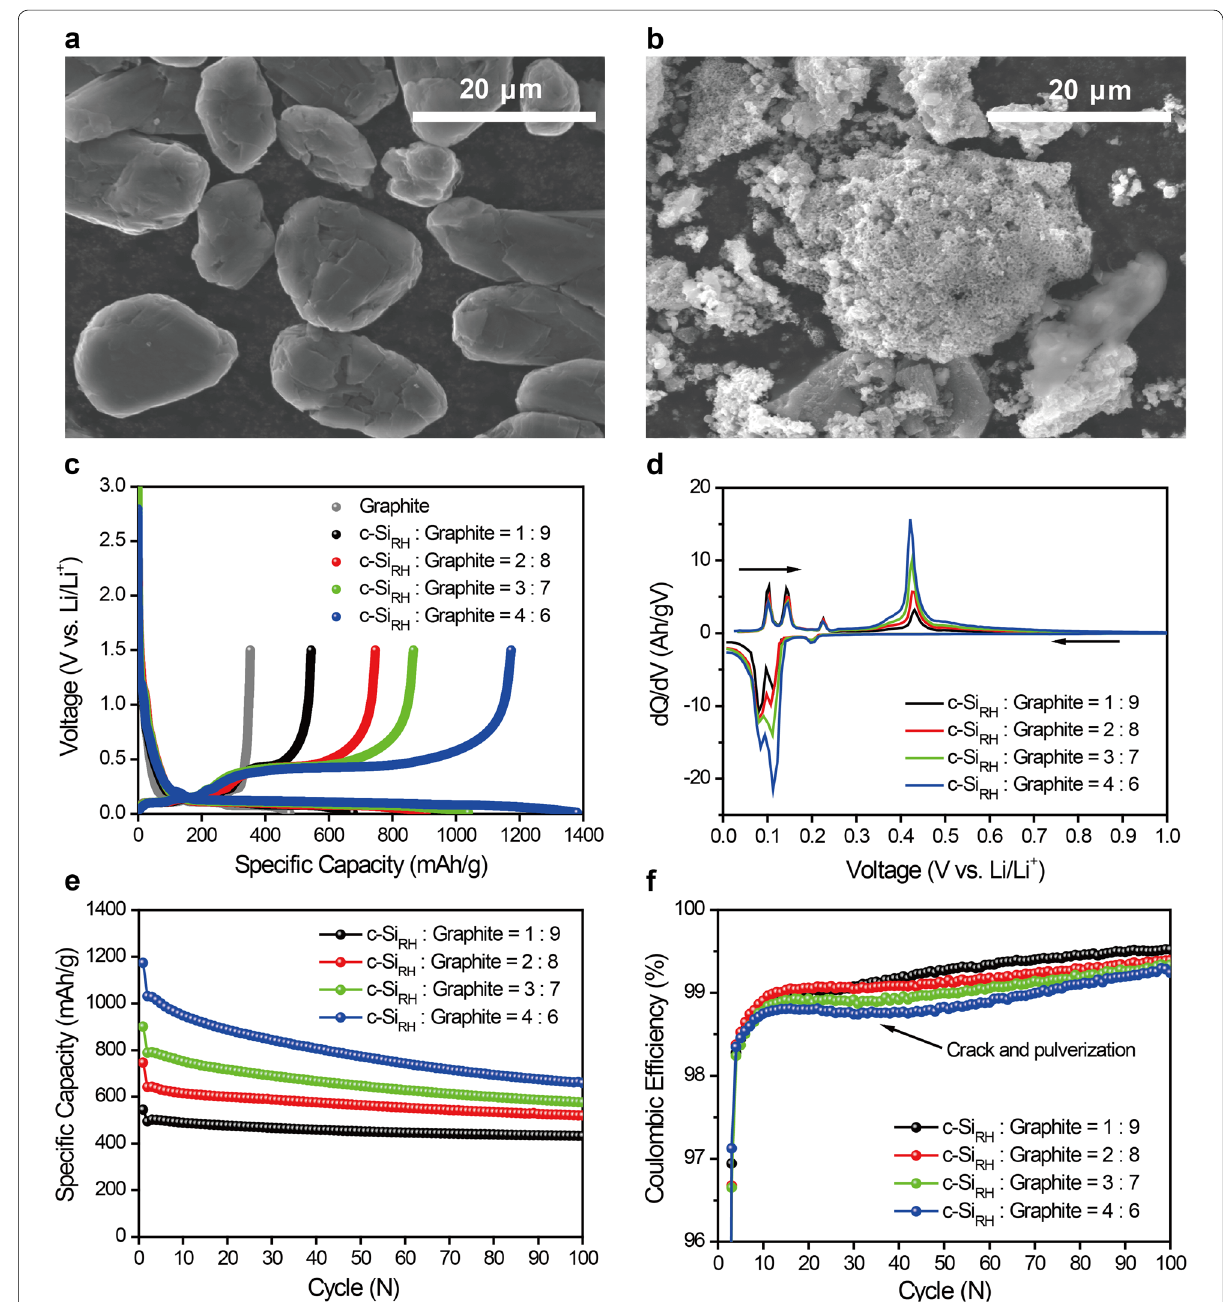
Fig. 2 Characterization of c-Si RH and graphite composites with different c-Si RH and graphite mass ratios. SEM images of a graphite and b c-Si RH . c Galvanostatic charge–discharge profiles. d Differential capacity plots. e Cycling performance at a rate of 1C for 100 cycles (1C 1100 mAh/g, respectively), and f corresponding Coulombic